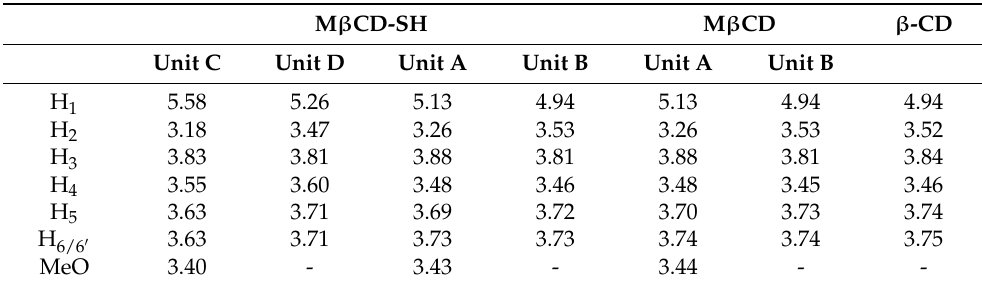
Figure 2. 1 H NMR (600 MHz, D 2 O, 25 °C, 5 mg/mL) spectra of ( a ) MβCD and ( b ) MβCD -SH. Table 1. 1 H NMR chemical shift (600 MHz, D 2 O, 25 °C, 5 mg/mL) of MβCD - SH, MβCD, and β -CD. Table 1. 1 H NMR chemical shift (600 MHz, D 2 O, 25 ◦ C, 5 mg/mL) of M β CD-SH, M β CD, and β